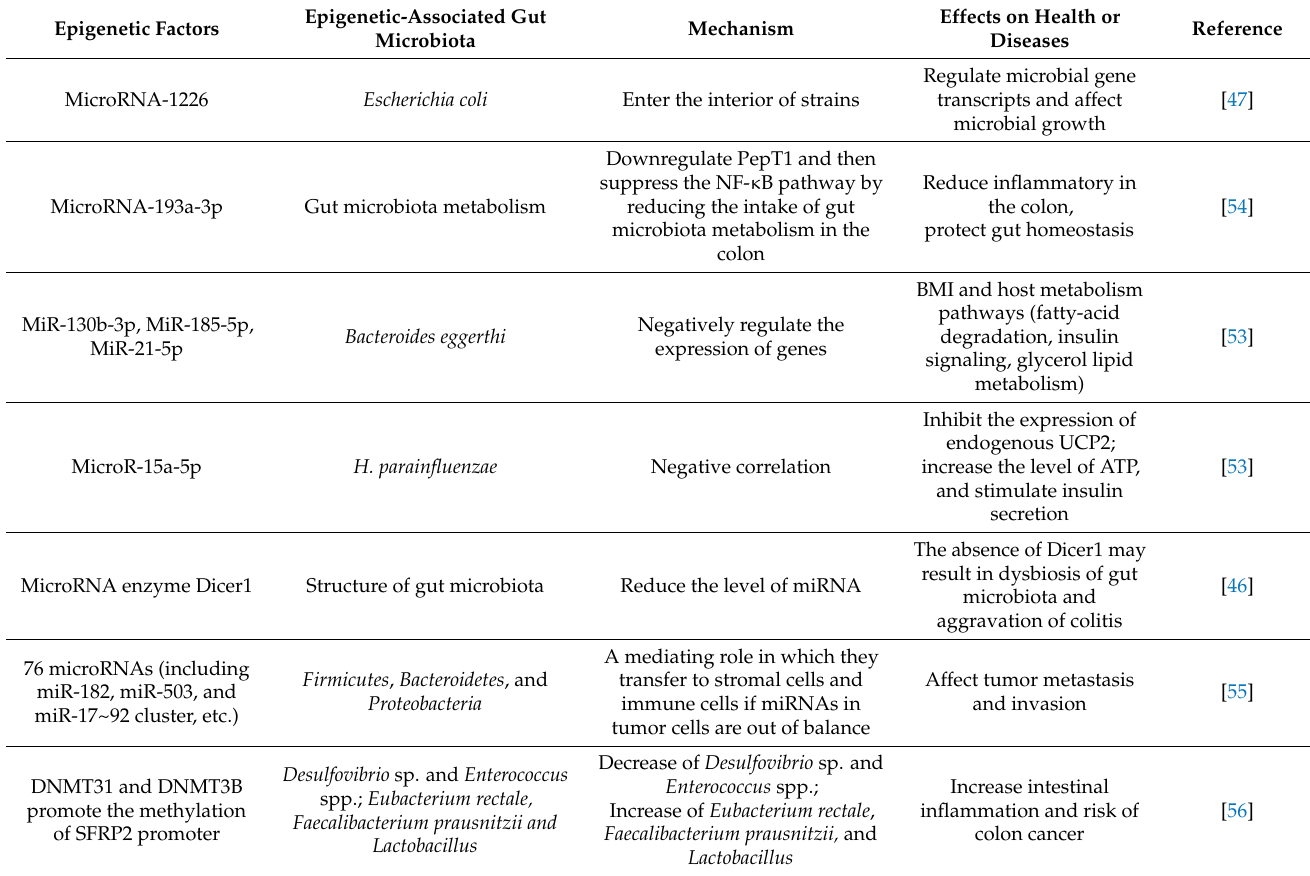
Table 1. Mechanisms of epigenetic modifications that regulate gut